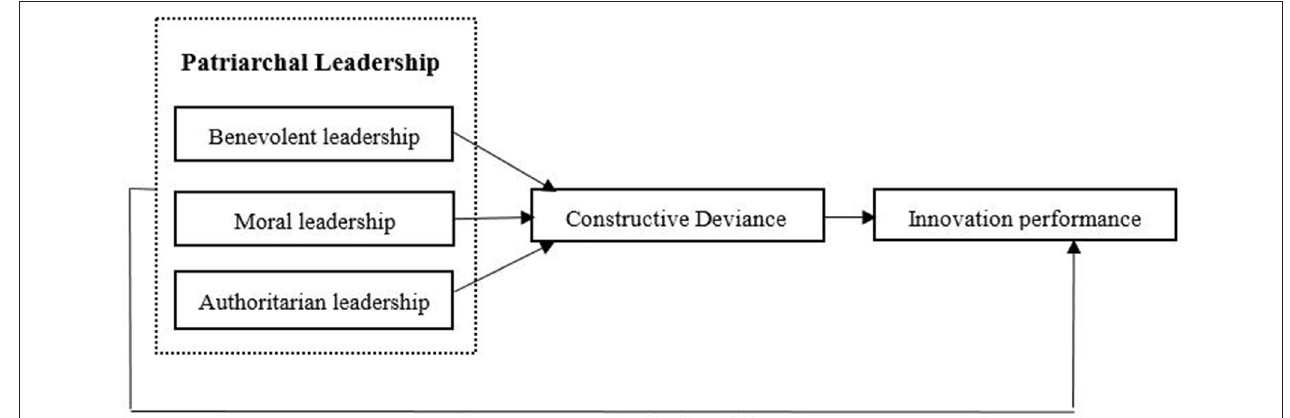
FIGURE 1 | Hypothesized